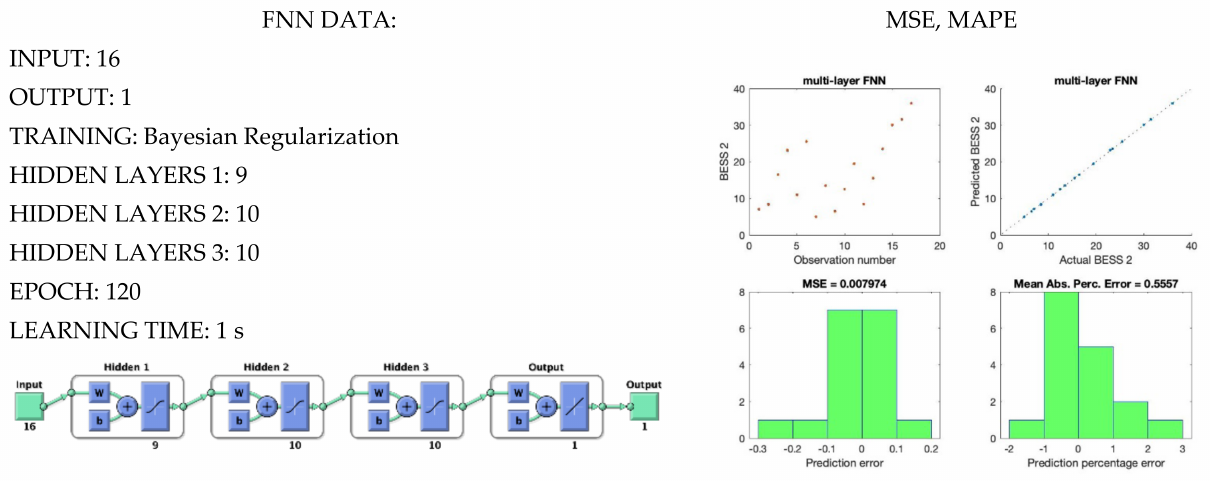
Figure 19. FNN machine learning results for BESS 2.